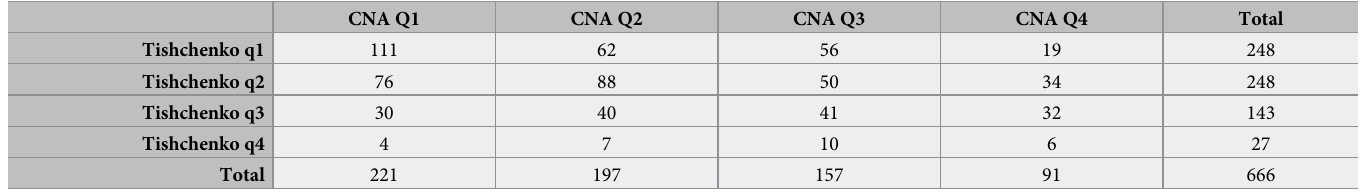
Table 2. Two-way table of patient counts in CNA Quartiles and gene expression quantiles of Tishchenko et al [13] for ordinary luminal A